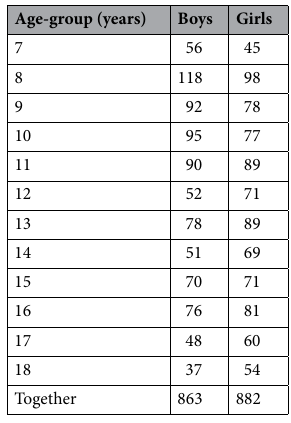
Table 1. Case numbers by age-groups and sex.